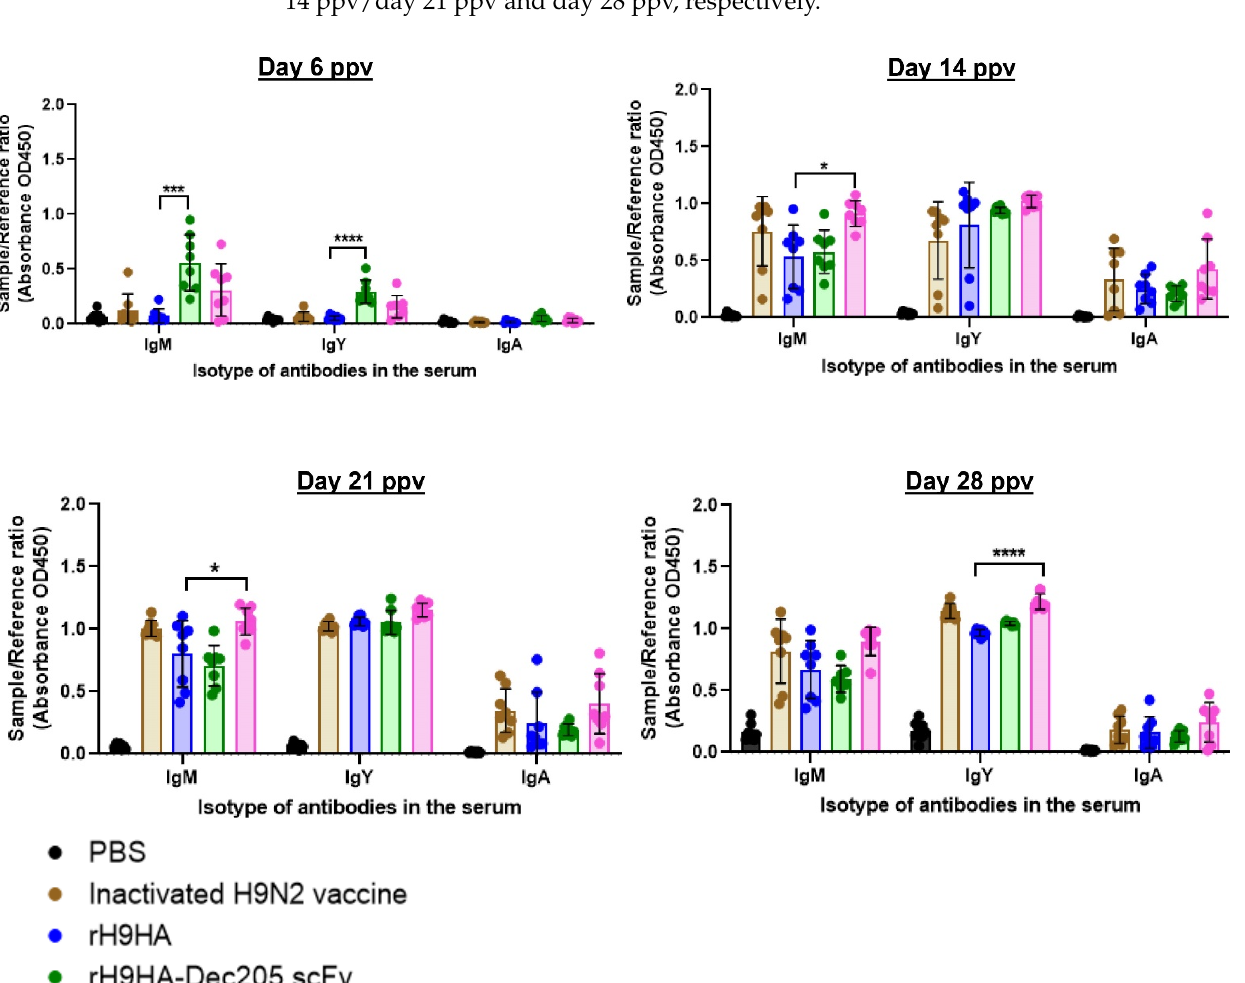
Figure 7. HA-specific IgM, IgY, and IgA antibodies in the serum of chickens immunised with 35 µ g dose of rH9HA, rH9HA-Dec205 scFv, rH9HA-CD11c scFv, and inactivated H9N2 vaccines. The HA-specific isotypes of the antibodies were determined in 200-fold diluted sera collected on day 6, 14, 21, and 28 post primary vaccination (ppv) by ELISA. The plates were coated with 1 µ g of recombinant H9HA protein overnight at 4 ◦ C. For detection, the plates were incubated with respective sera for one hour at room temperature. This was followed by further incubation for one hour with 1:3000 diluted anti-chicken IgM, IgY, and IgA antibodies. The colorimetric detection was carried out by adding TMB substrate and absorbance at 450 nm was recorded. The amount of HA specific IgM, IgY and IgA antibodies were expressed as sample to reference ratio (relation of absorbance of tested serum sample to absorbance of the reference serum). Data are presented as mean ± SD and analysed by one-way ANOVA followed by Tukey’s multiple comparison test. **** p < 0.0001, *** p < 0.001, * p < 0.05.